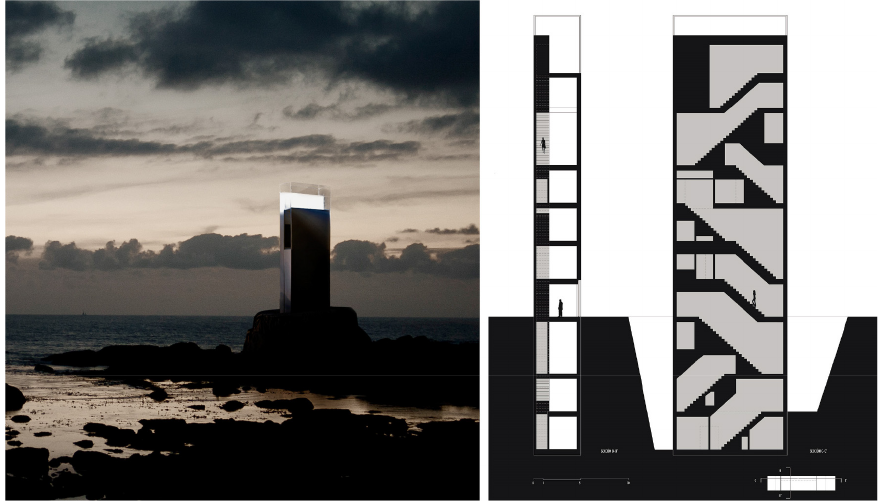
Figure 7. The cyclops of the sea. Student: Isis Pérez